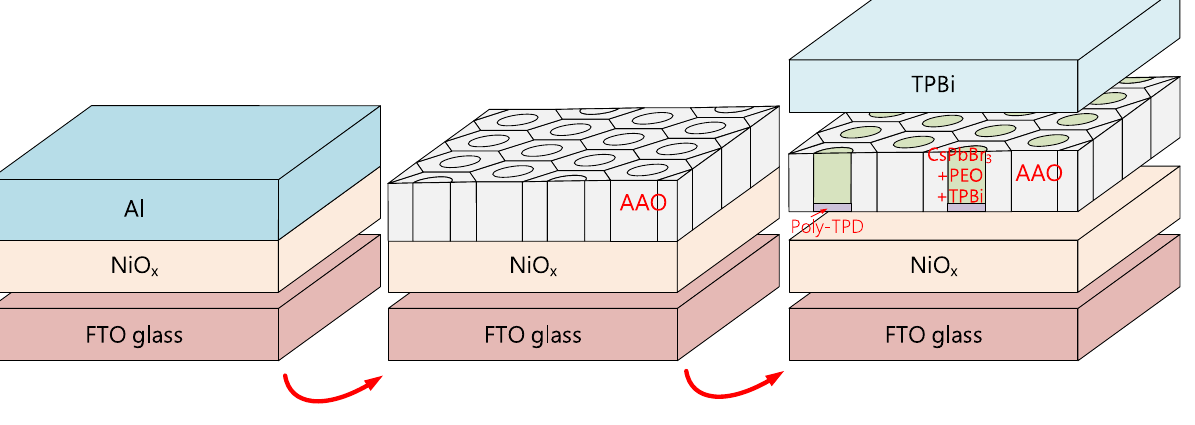
Figure 1. Schematic diagram of the device process